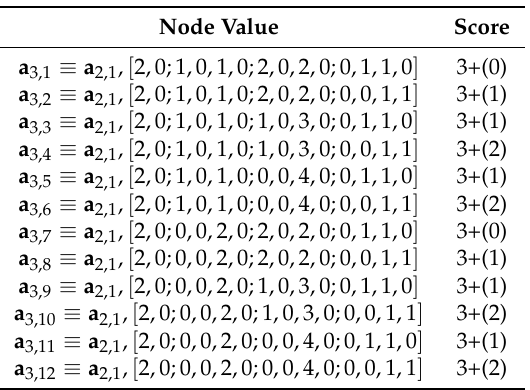
Table 1. Node values and scores for the child nodes of a 2,1 in branch and bound with an admissible heuristic for van der Pol